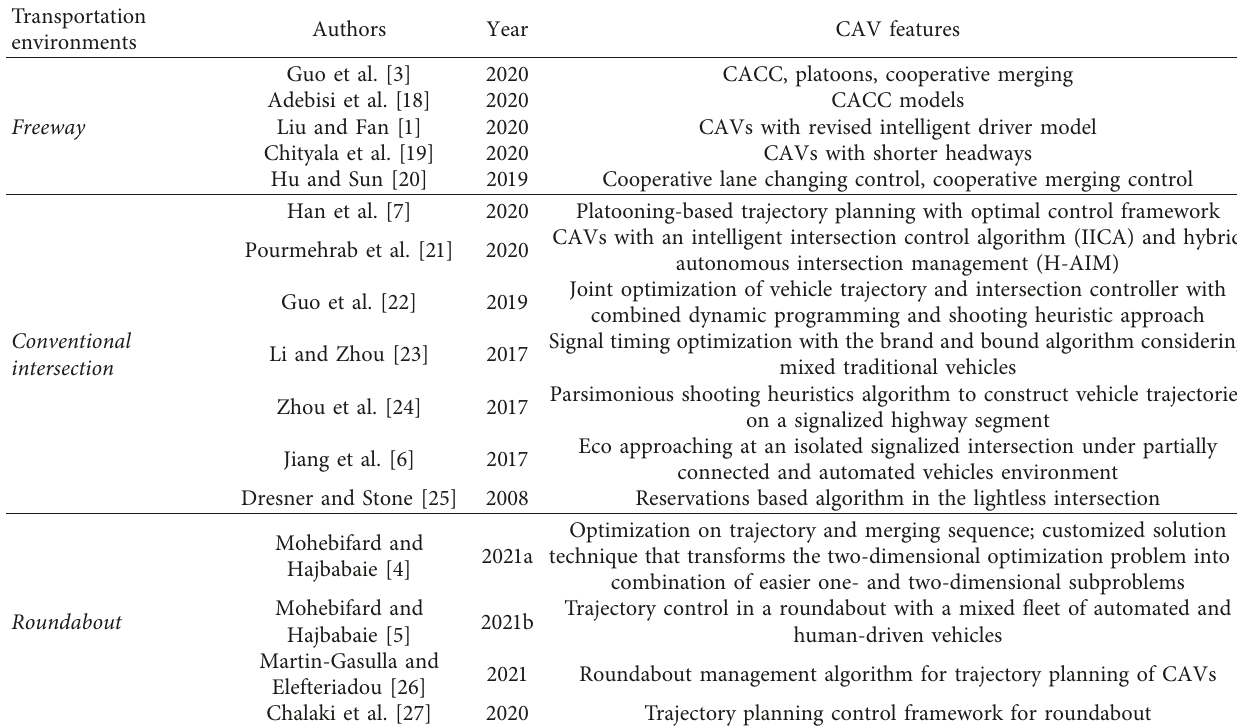
Table 1: Recent studies on the CAVs categorized by transportation